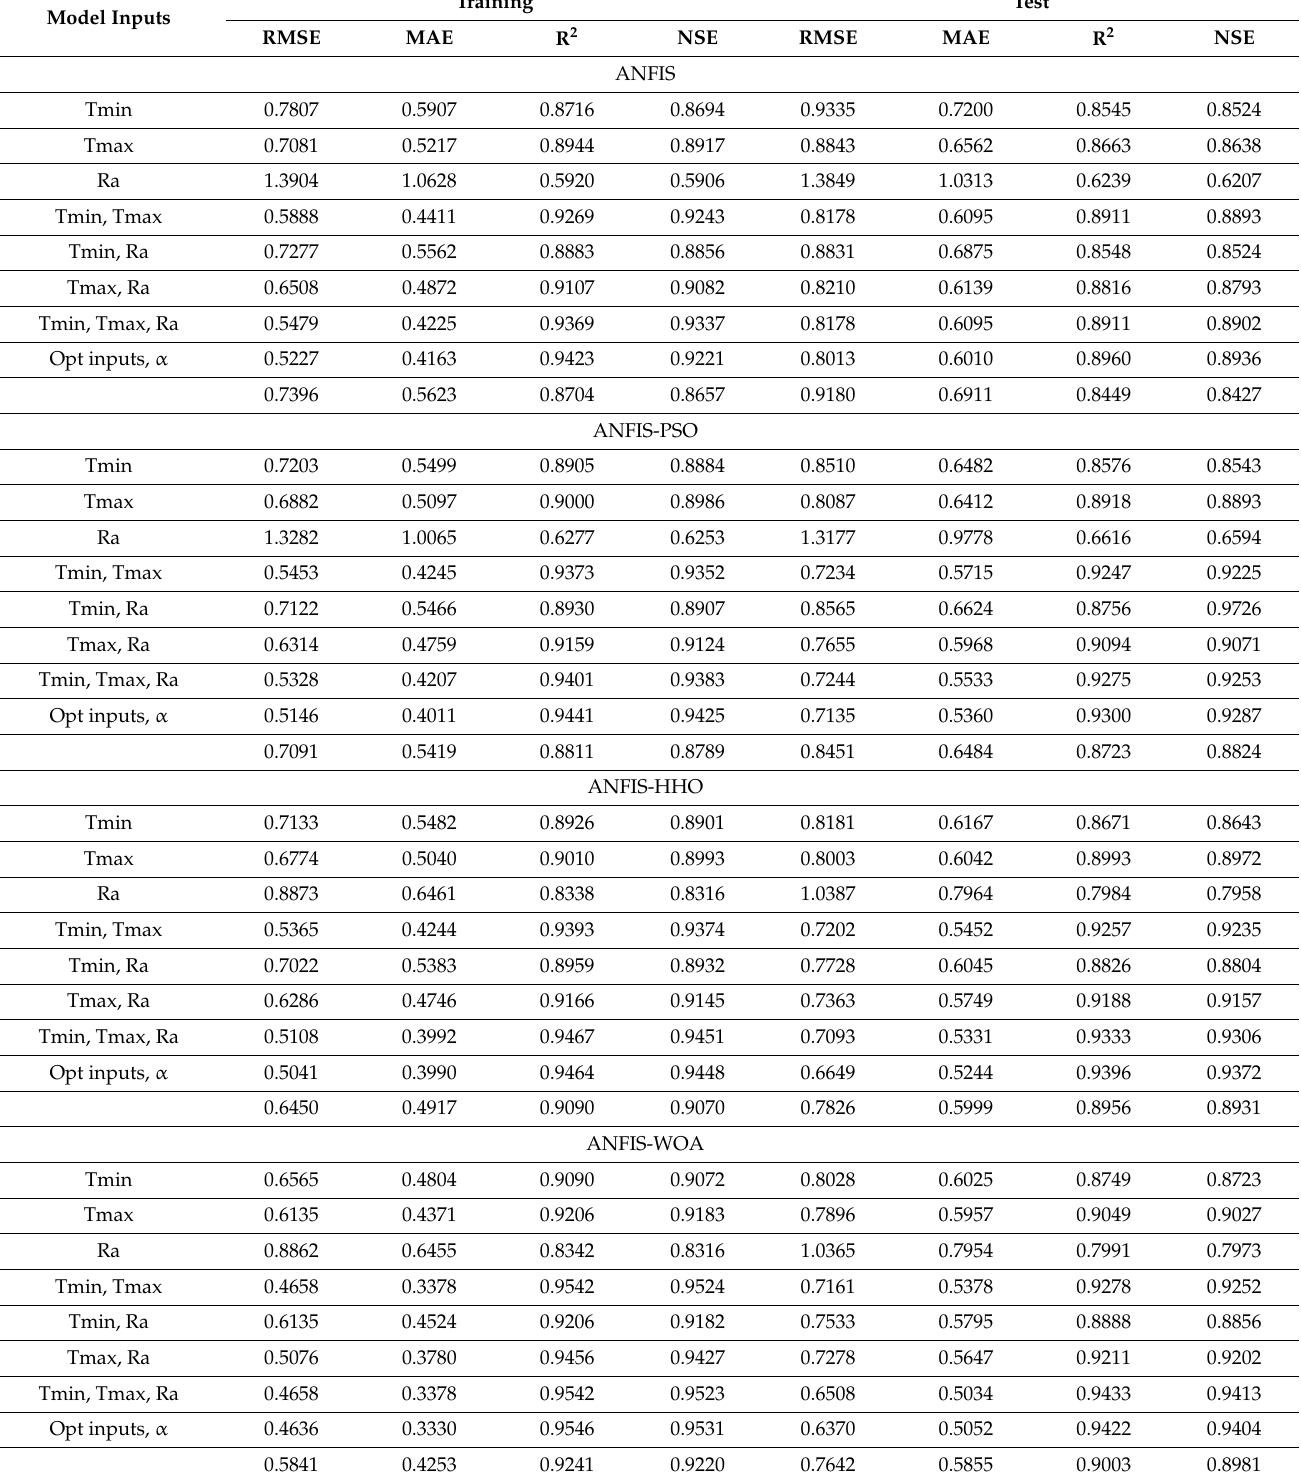
Table 6. Training and testing performances of the models for monthly Epan prediction—Yueyang